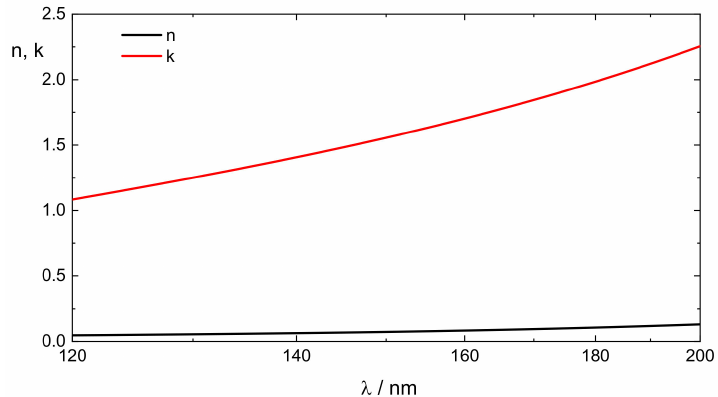
Figure 2. VUV optical constants of